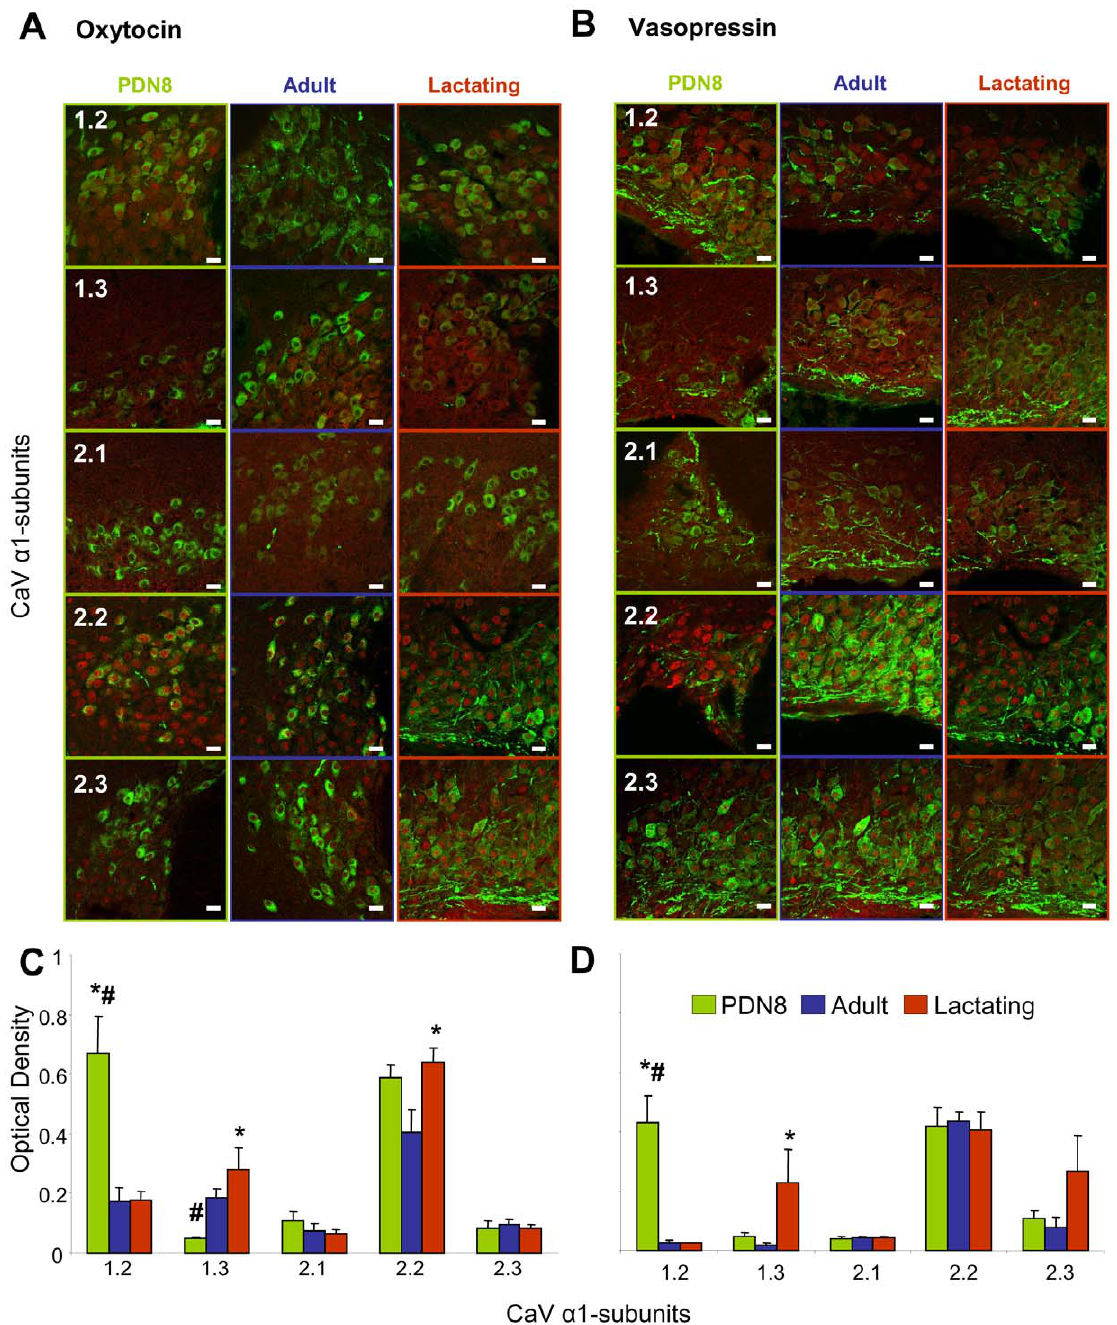
Figure 2. Ca 2 + channel distribution in tissue sections of SON. ( A ) Immunostaining for Ca v subunits (red staining) and oxytocin ( A ) or vasopressin ( B ) (green staining) in SON sections from PND-8, adult, and lactating rats. Average optical density for the subunits normalised by the optical density of ( C ) oxytocin and ( D ) vasopressin (n=5). No labelling was detected when primary antibodies were omitted or incubated with a five- fold excess of control immunogen before being exposed to the tissues (not shown). Means 6 S.E.M. vs adult, # P , 0.05 vs lactating rats, one-way ANOVA followed by Holm-Sidak post-hoc test. Scale bars, 20 m m.